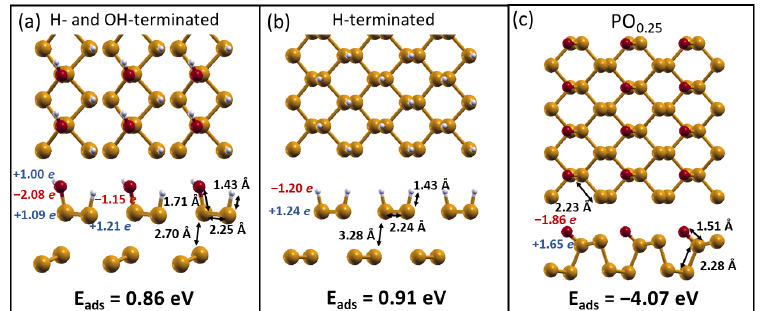
Figure 2. Top ( upper panel ) and lateral ( lower panel ) views of the optimized structures of one-sided functionalized phosphorene substrates covered in -OH and H ( a ), H ( b ), and O ( c ) atoms. The adsorption energies for each molecule are reported.